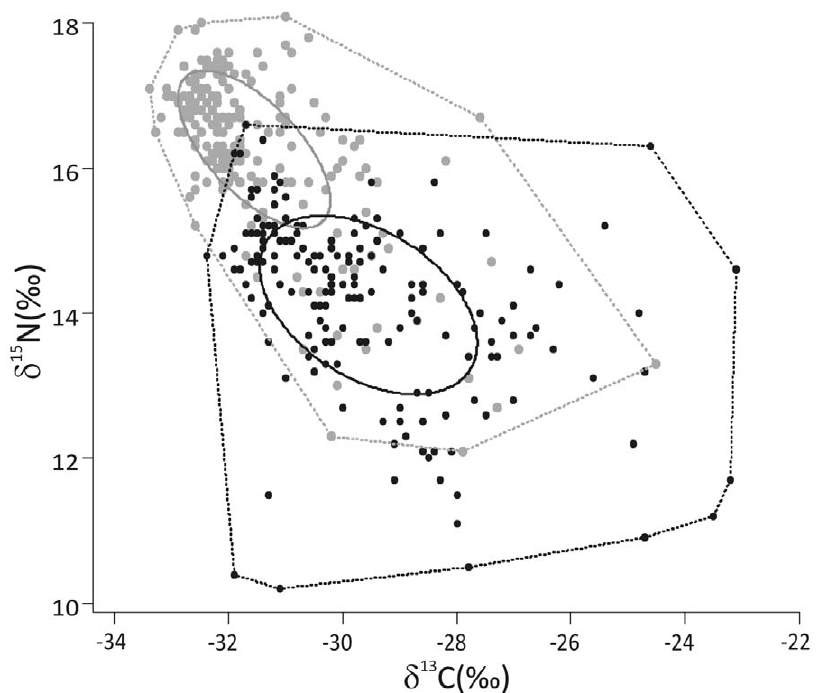
Figure 3. Perch and roach isotope niche width estimates from Lake Jyva¨sja¨rvi. Standard ellipse areas (SEA, solid lines) and convex hull TA (dashed lines) are estimated for perch (grey symbols and lines) and roach (black symbols and lines) populations using SIBER [18].